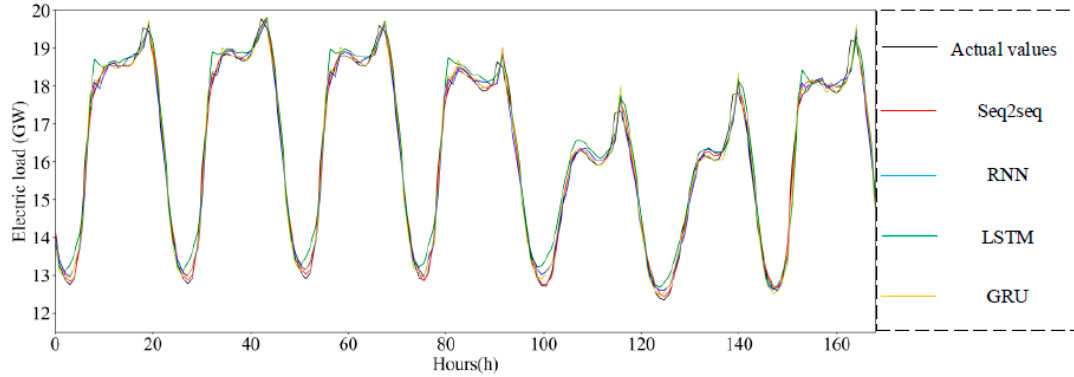
Figure 14. Forecast comparison chart under different methods.